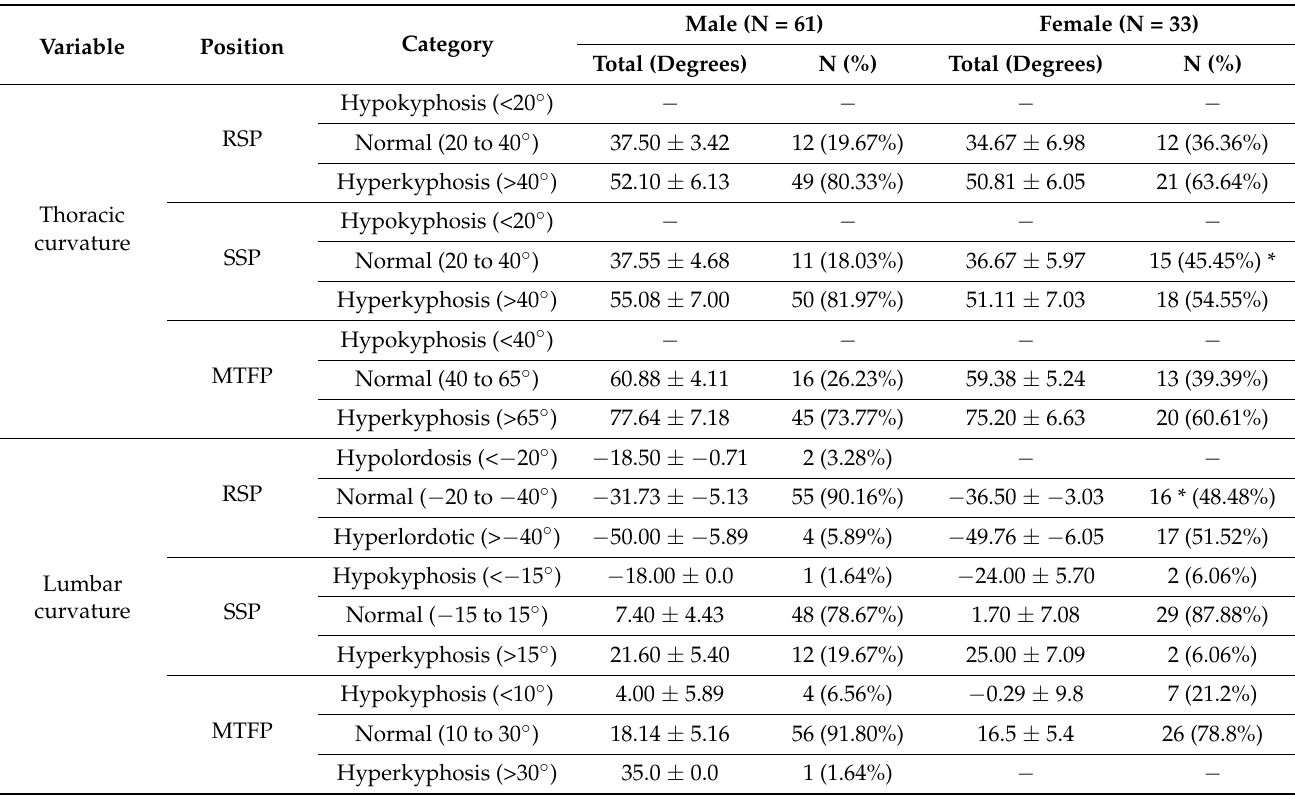
Table 2. Absolute and relative frequencies of 94 competitive amateur athletes within each curvature category in three positions according to normality references (Santonja-Medina et al., [40]).